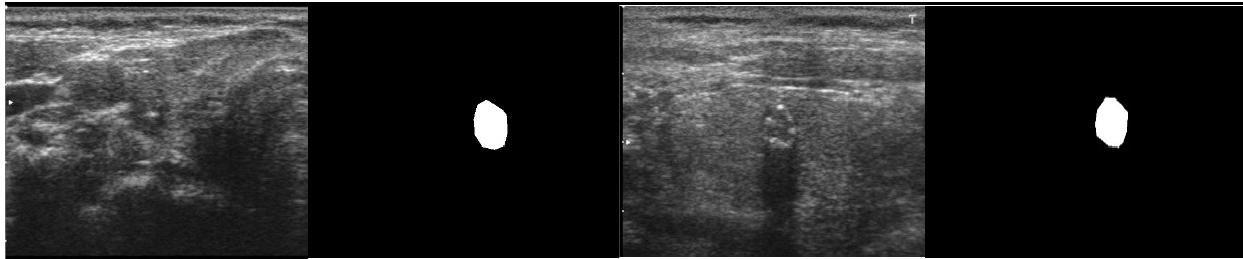
Figure 3. Original image and its corresponding GT masks.